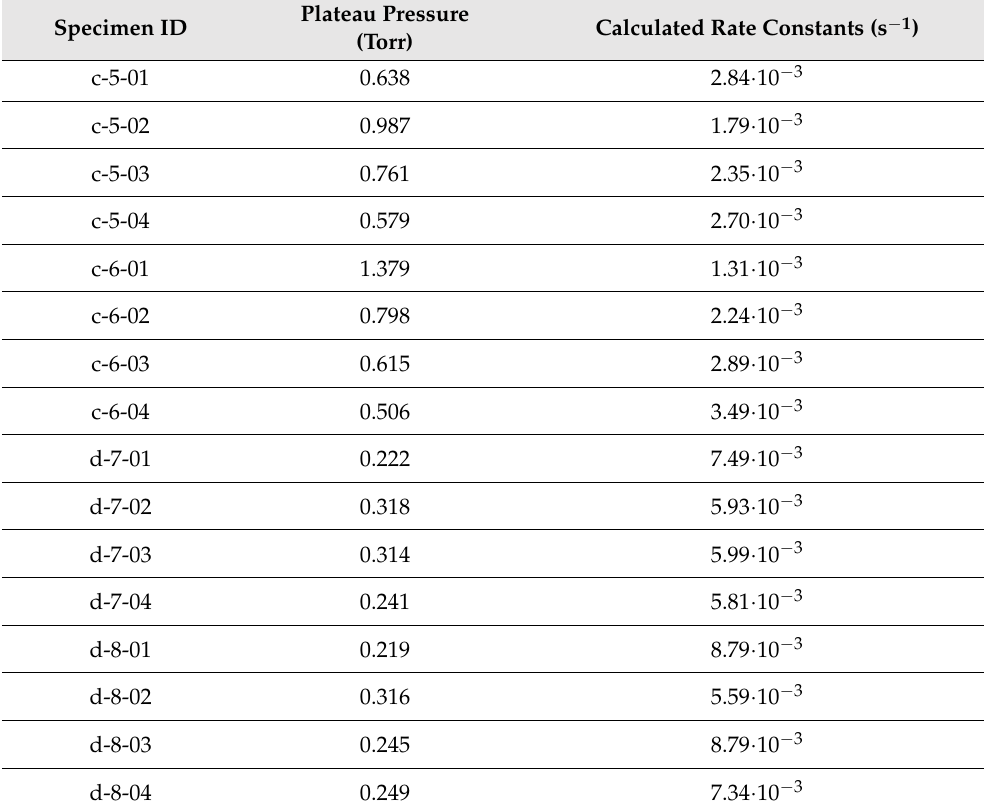
Table 3. Test Matrix for XPS analysis of NPG specimens .